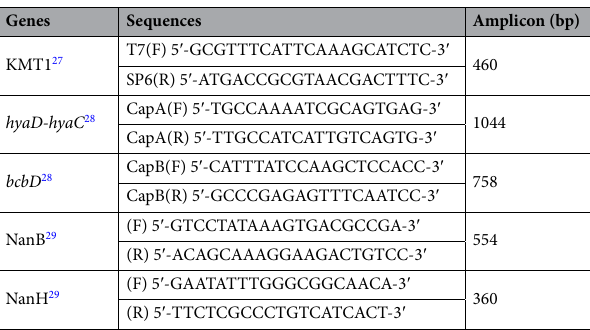
Table 1. List of Primers for Identification of Pasteurella multocida